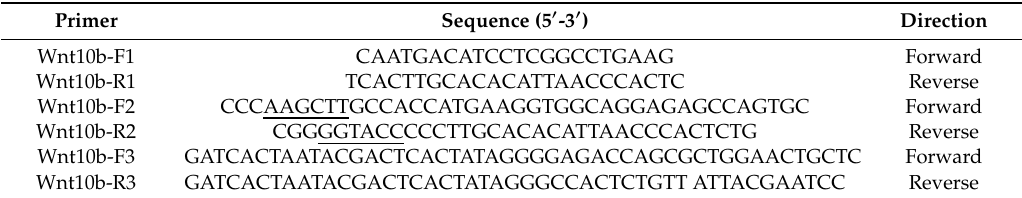
Table 1. Sequence of the primers used in this